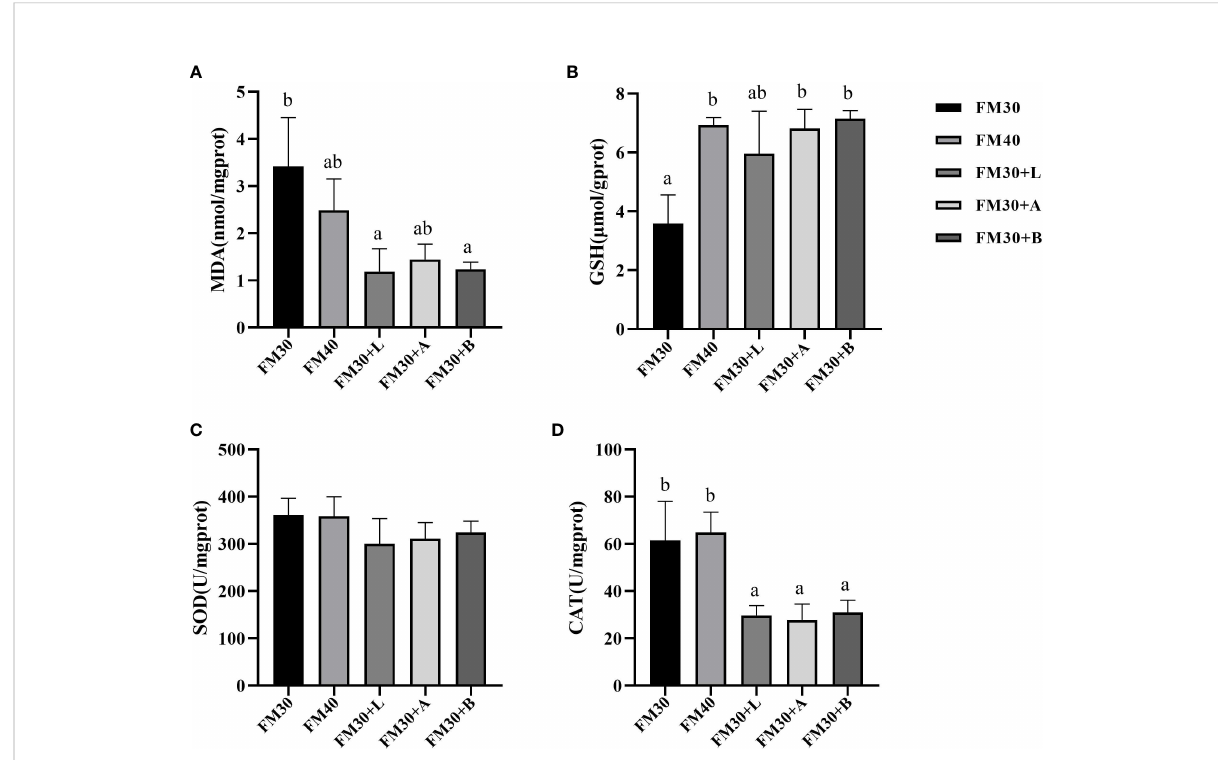
FIGURE 2 Effects of limonene, allicin and betaine on liver antioxidant capability of M. salmoides for 9 weeks. (A) Malondialdehyde (MDA); (B) glutathione (GSH); (C) superoxide dismutase (SOD); (D) catalase (CAT). Values (mean ± standard error of the mean, SEM) in bars that have the same letter are not signi fi cantly different (P > 0.05) between